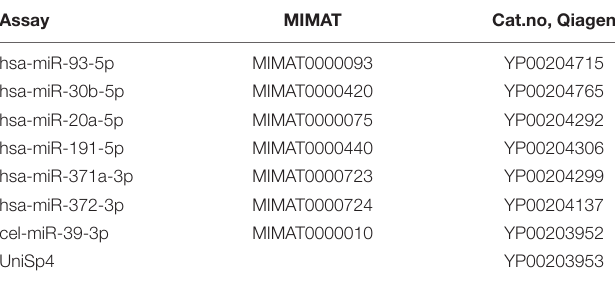
TABLE 1 | Assays used in pre-amplification and qPCR of microRNAs.